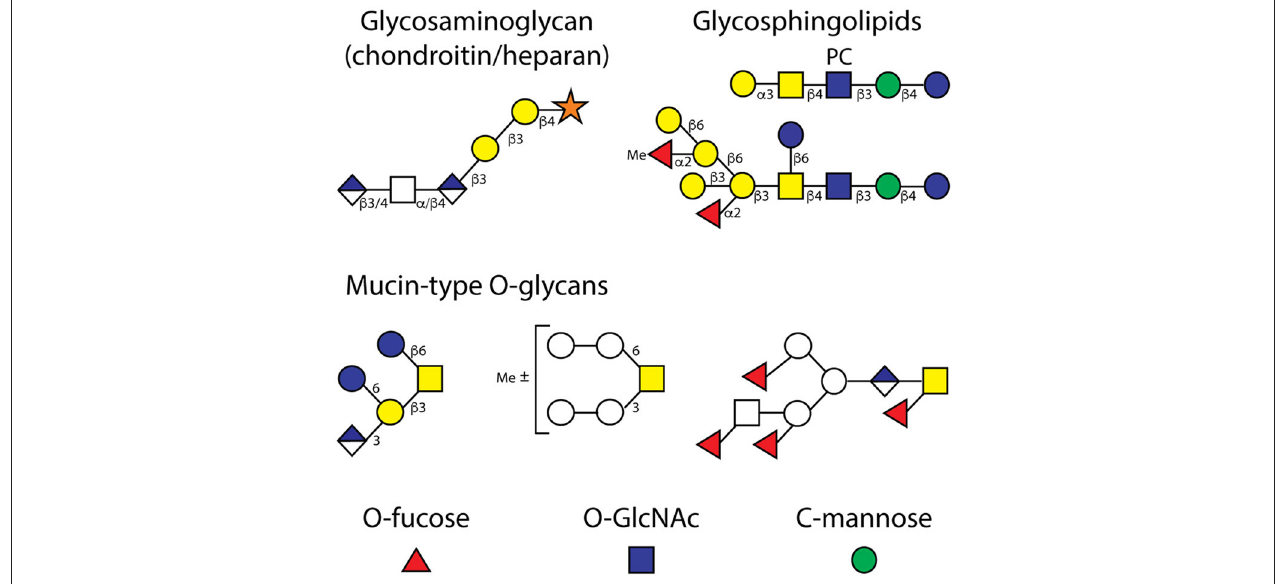
FIGURE 4 | Examples of O-glycans and glycolipids. Depicted are example structures of (i) O-linked glycosaminoglycans (the α / β 4 and β 3/4 indicate the difference between chondroitin and heparan chains), (ii) neutral and zwitterionic glycosphingolipids, (iii) “core I” and “core II” mucin-type O-glycans, whereby the latter with a GalNAc modified with fucose and glucuronic acid are unrelated to the core 2 structures found in mammals, and (iv) the simple monosaccharide modifications of EGF, TSR and cytosolic proteins (O-Fuc, O-GlcNAc, and C-Man). The glycolipid and O-glycan structures are based on the work of various laboratories (Gerdt et al., 1997,